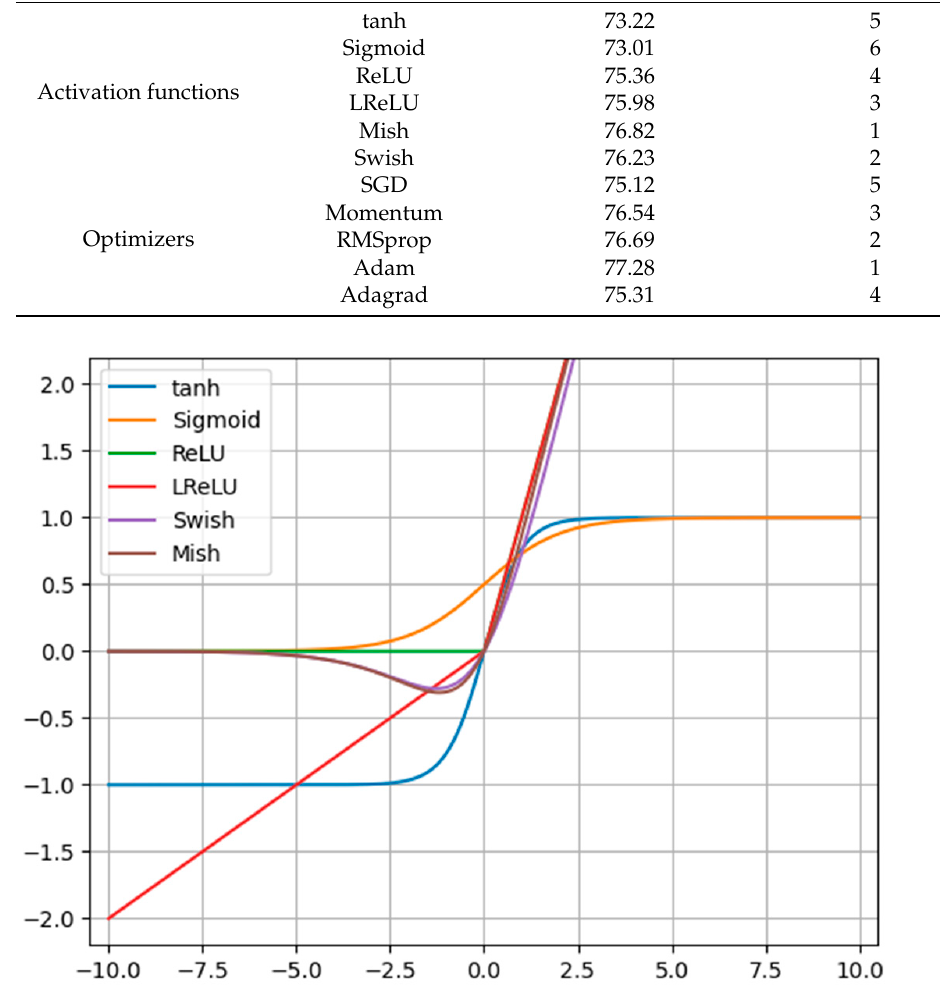
Figure 11. Schematic diagram of activation functions.